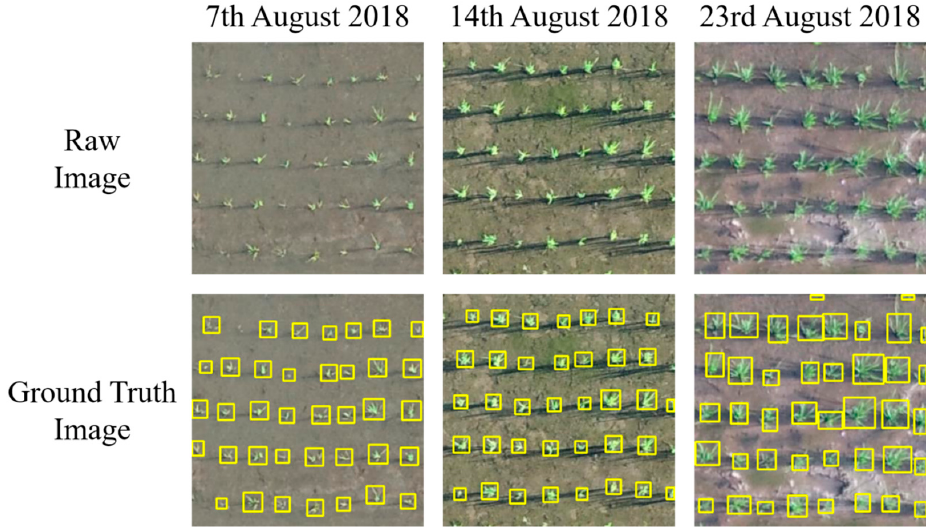
Figure 6. Examples of three growth stages of the rice seedling detection dataset.